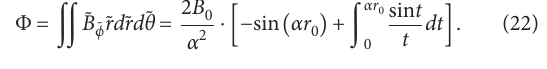
The EUHFORIA CME model in Pomoell and Poedts (2018) and Scolini et al. (2018) did not contain an intrinsic magnetic field and was injected at the inner radial boundary with the enhancement of velocity, density, and pressure. Verbeke et al. (2019) introduced a linear force-free spheromak (LFFS) solution to the EUHFORIA CME model. The CME was considered to be a sphere with a radius r = 0 . 1 au ⋅ sin ω / 2. The CME latitude and longitude ( θ , ϕ ) , mc CME CME angular width ω , and speed v were the same as in Pomoell and CME Poedts(2018).Locatedat ( 0 . 1 au − r , θ , ϕ ) ,theCMEmoved mc CME CME throughthe0.1 auboundarywithspeed v .Apointat ( 0 . 1 au , θ , ϕ ) CME satisfied the following formula was inside the CME − x − y − z , ( x ) 2 +( y ) 2 +( z ) 2 ≤ r CME bound CME bound mc CME bound